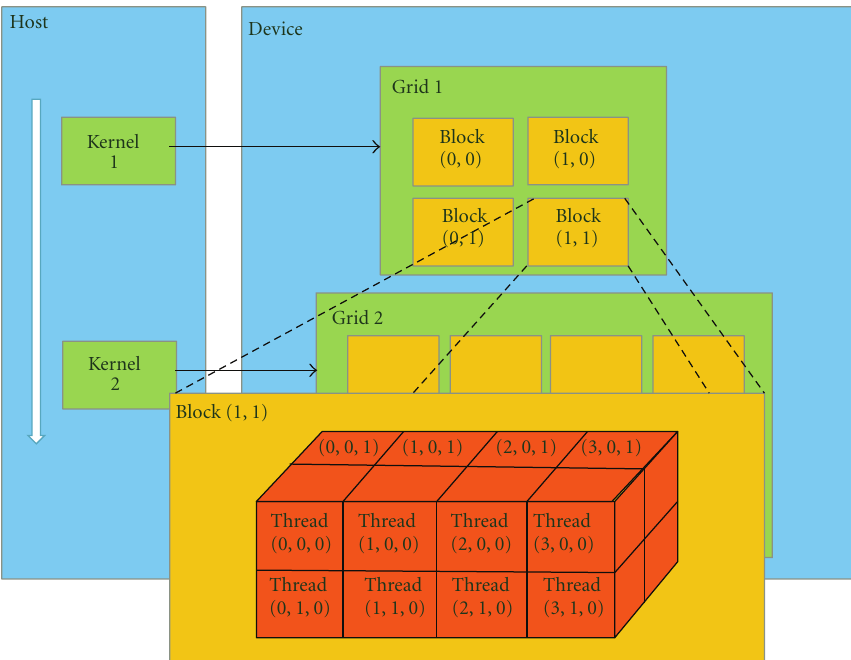
Figure 1: CUDA-processing model design [22].